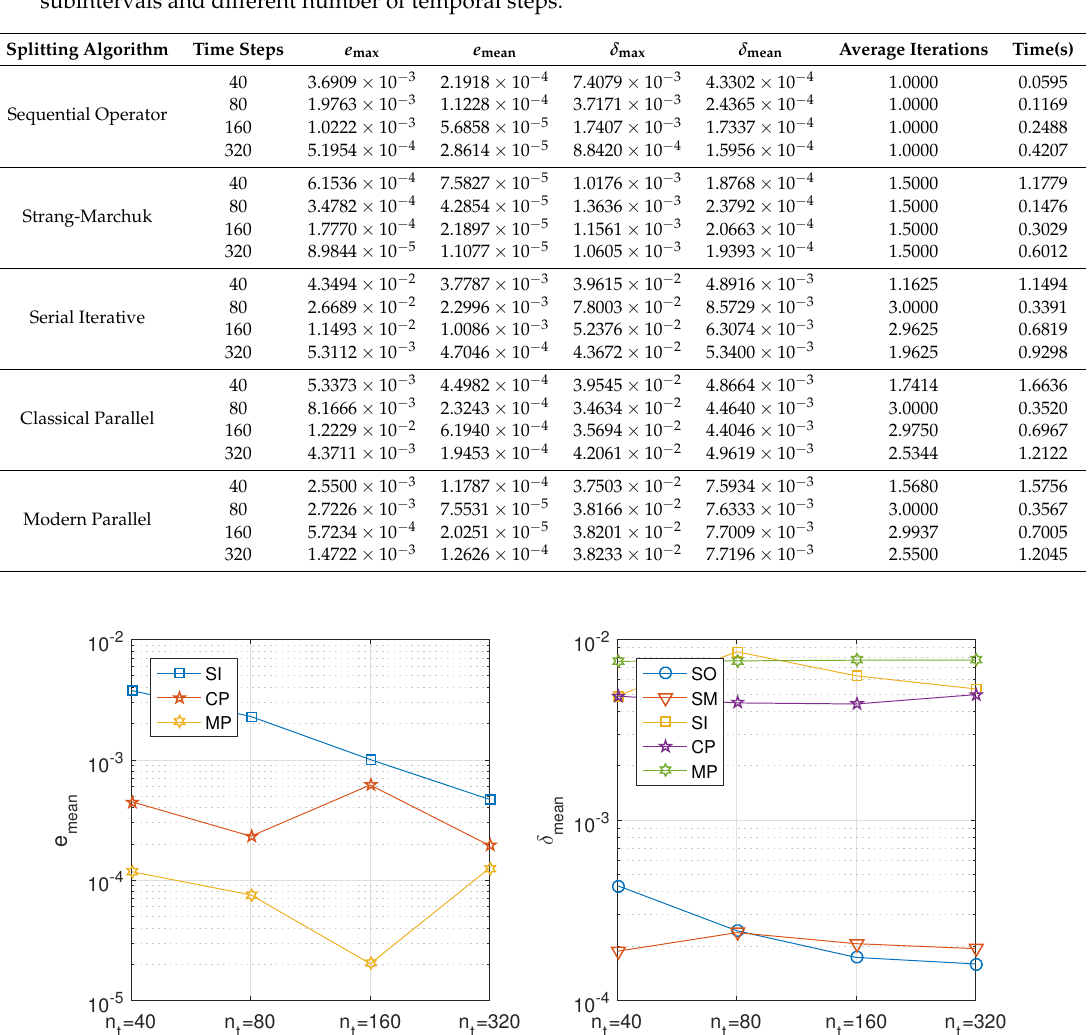
Table 17. Fractional diffusion equation. Results for the directional decomposition with 20 spatial subintervals and different number of temporal steps.